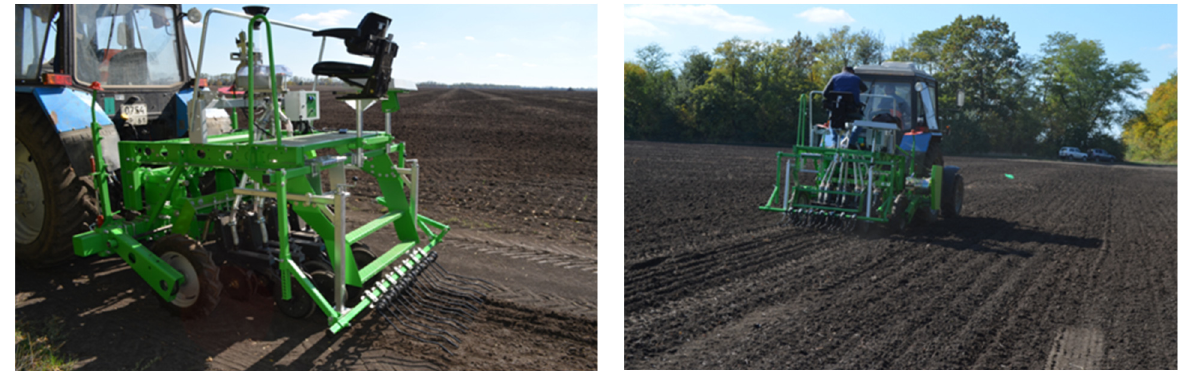
Figure 3. Trititrigia sowing with the Demetra seeder. Trititrigia seeds were sown with a recommended seeding rate of 4.3 million pcs ha (150 kg ha − 1 ). Seeds of winter wheat “Stanichnaya” were sown with the recommended seeding rate of 5.5 million pcs ha − 1 (220 kg ha − 1